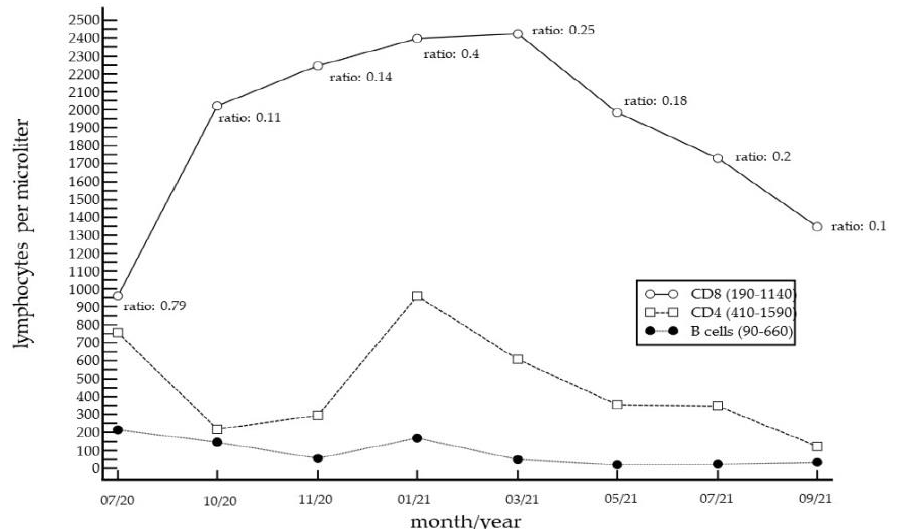
Figure 2. Timeline of peripheral lymphocyte subpopulation counts, from July 2020 to September 2021. The CD4/CD8 ratio (normal range: 0.8–2) is shown underneath the graph for CD8 T cells. Before PAMS developed, the ratio was close to normal (0.79 in 07/20), and then remained consistently low due to highly increased CD8+ lymphocyte counts. Of note, CD20+ B-cell counts were also low over most of the time.